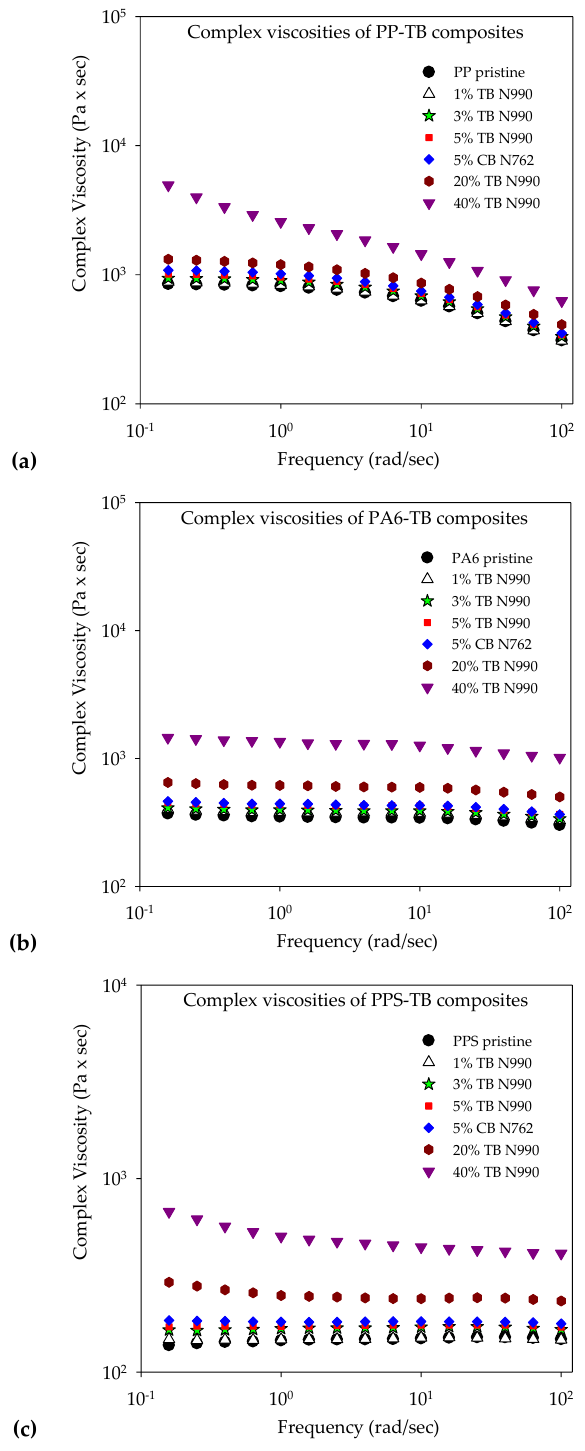
Figure 4. Complex viscosity curves of: ( a ) PP/TB N990, ( b ) PA6/TB N990, and ( c ) PPS/TB N990 composites.